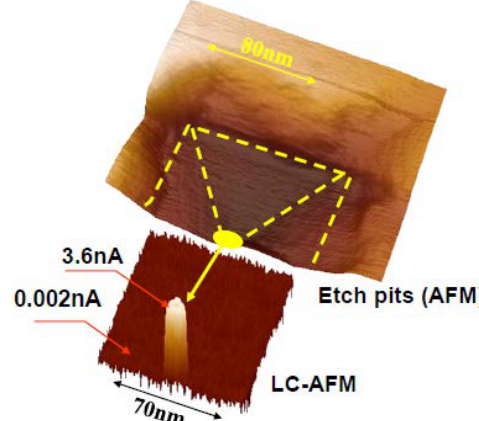
Figure 40. The position of etch pits determined by AFM topography and the coinciding position of filaments with enhanced conductivity (by LCAFM) shown in the surface layer of the (100) face of a reduced SrTiO 3 crystal. The SrTiO 3 has been extensively etched and subsequently annealed at 1023 K for 30 min at p O2 = 10 − 9 mbar (adapted from [51]).